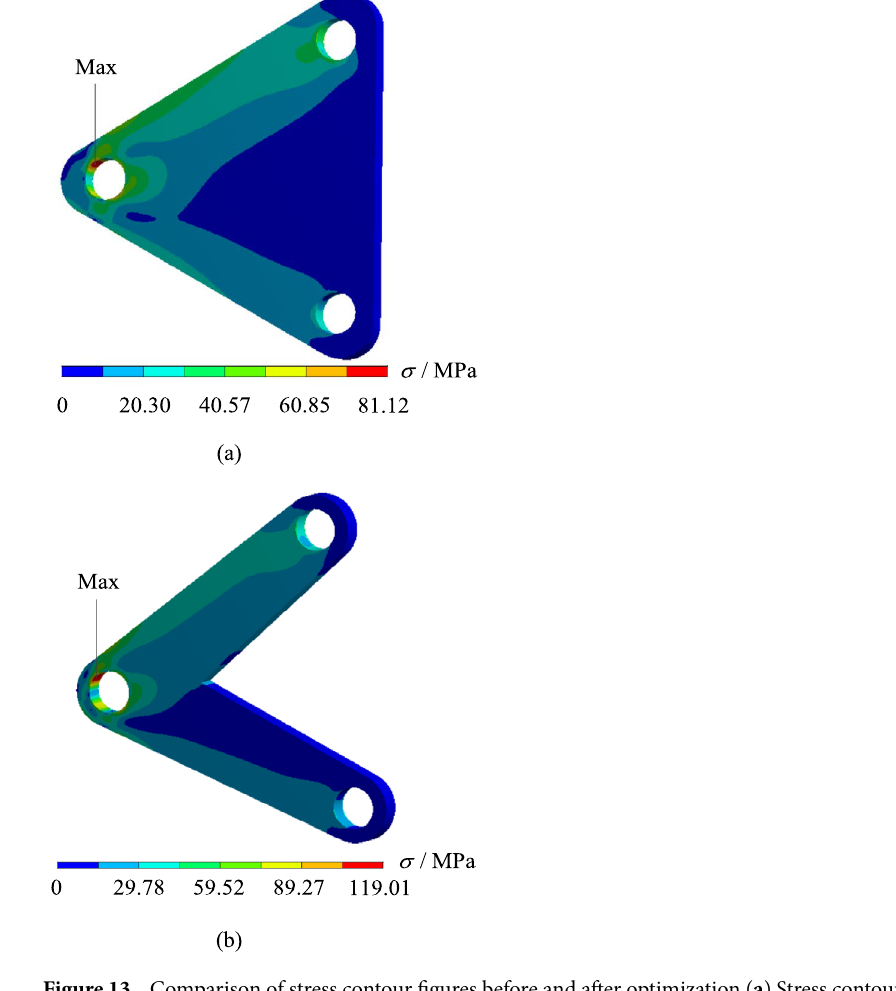
Figure 13. Comparison of stress contour figures before and after optimization.( a ) Stress contour figure of the original model ( b ) Stress contour figure of the reconstructed